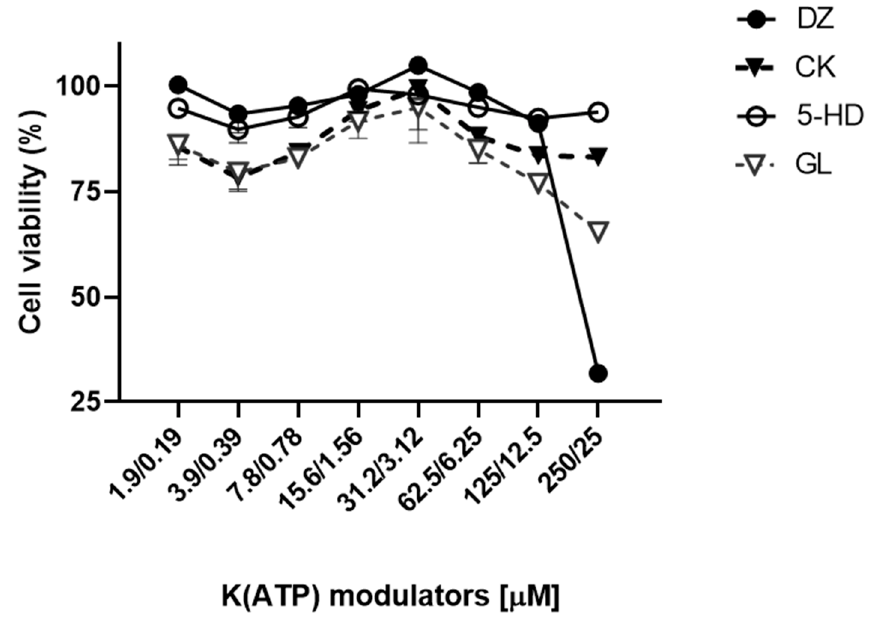
Figure 1. MTT assay with the rat IL2 lung epithelial cells exposed for 24 h to increasing concentrations of the different K(ATP) channel modulators. We performed two-fold dilution of the K(ATP) channel modulators with starting concentration of 250 µM for DZ, 5-HD, and GL or 25 µM for CK. Average results of three experiments with % CV.